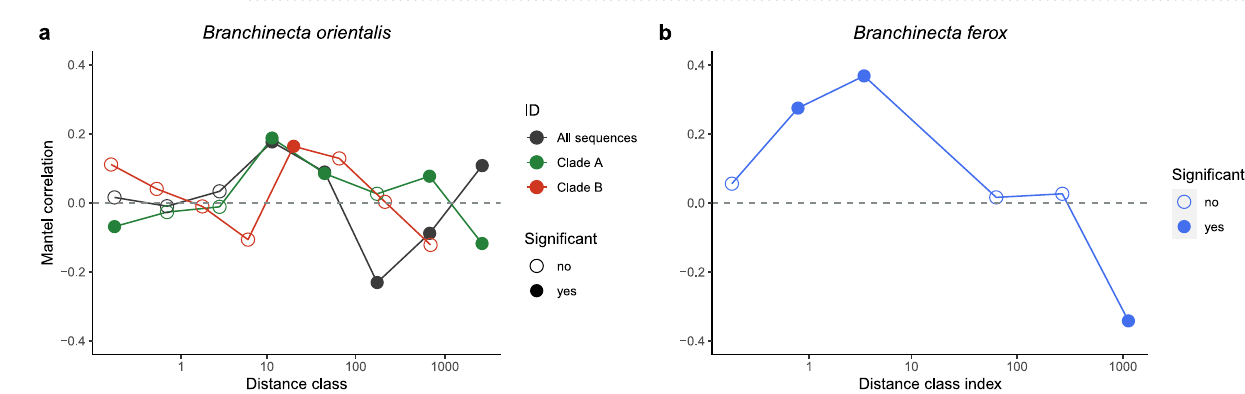
Figure 4. Mantel correlogram for genetic distance (Hellinger-transformed) and geographic distance (log- transformed) in ( a ) Branchinecta orientalis (black – all sequences; green – Clade A; red – Clade B; for the clades, see Fig. 2a,c) and ( b ) Branchinecta ferox based on the mitochondrial COI gene fragment. The circles indicate significant correlation within a distance class, tested within eight distance classes in each of the three datasets of B. orientalis and seven distance classes in B. ferox